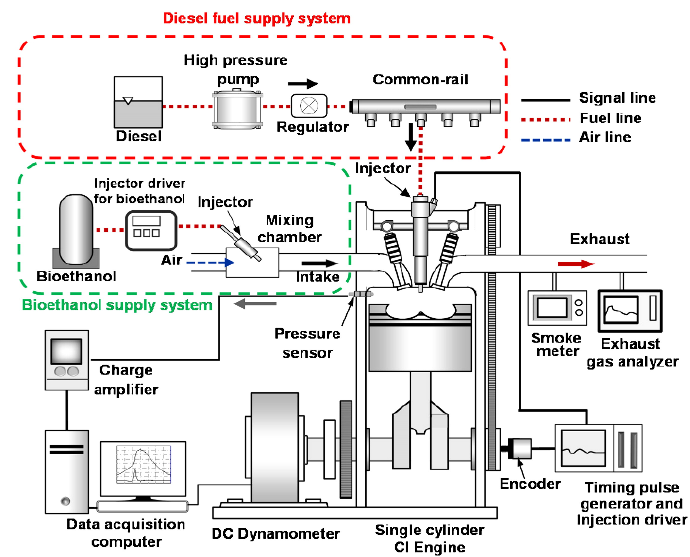
Figure 1. The Control devices of the one-cylinder engine parameters and dynamometer .